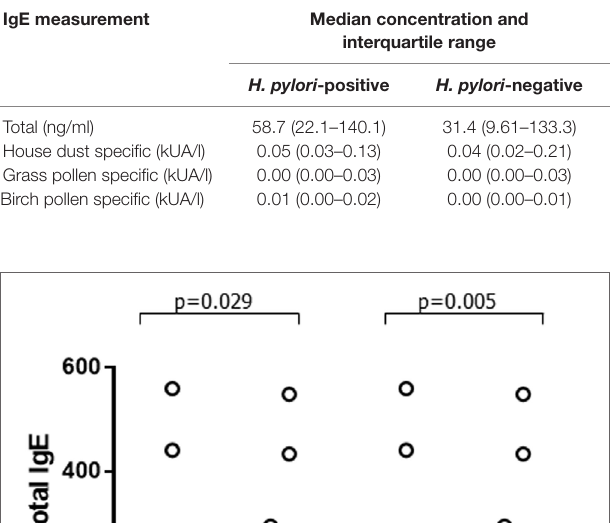
TaBle 2 | Total and allergen-specific ige levels in the plasma of 49 infected and 46 uninfected patients. ige measurement